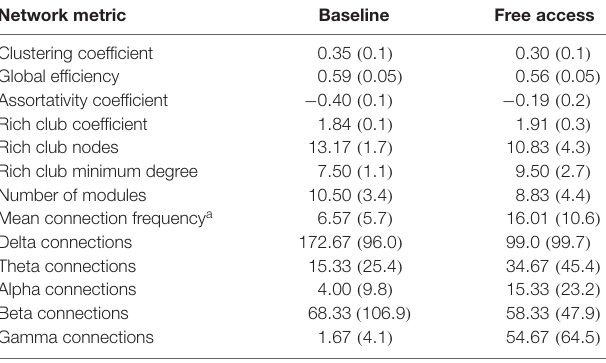
TABLE 2 | Descriptive statistics of network metrics prior to and following exposure to